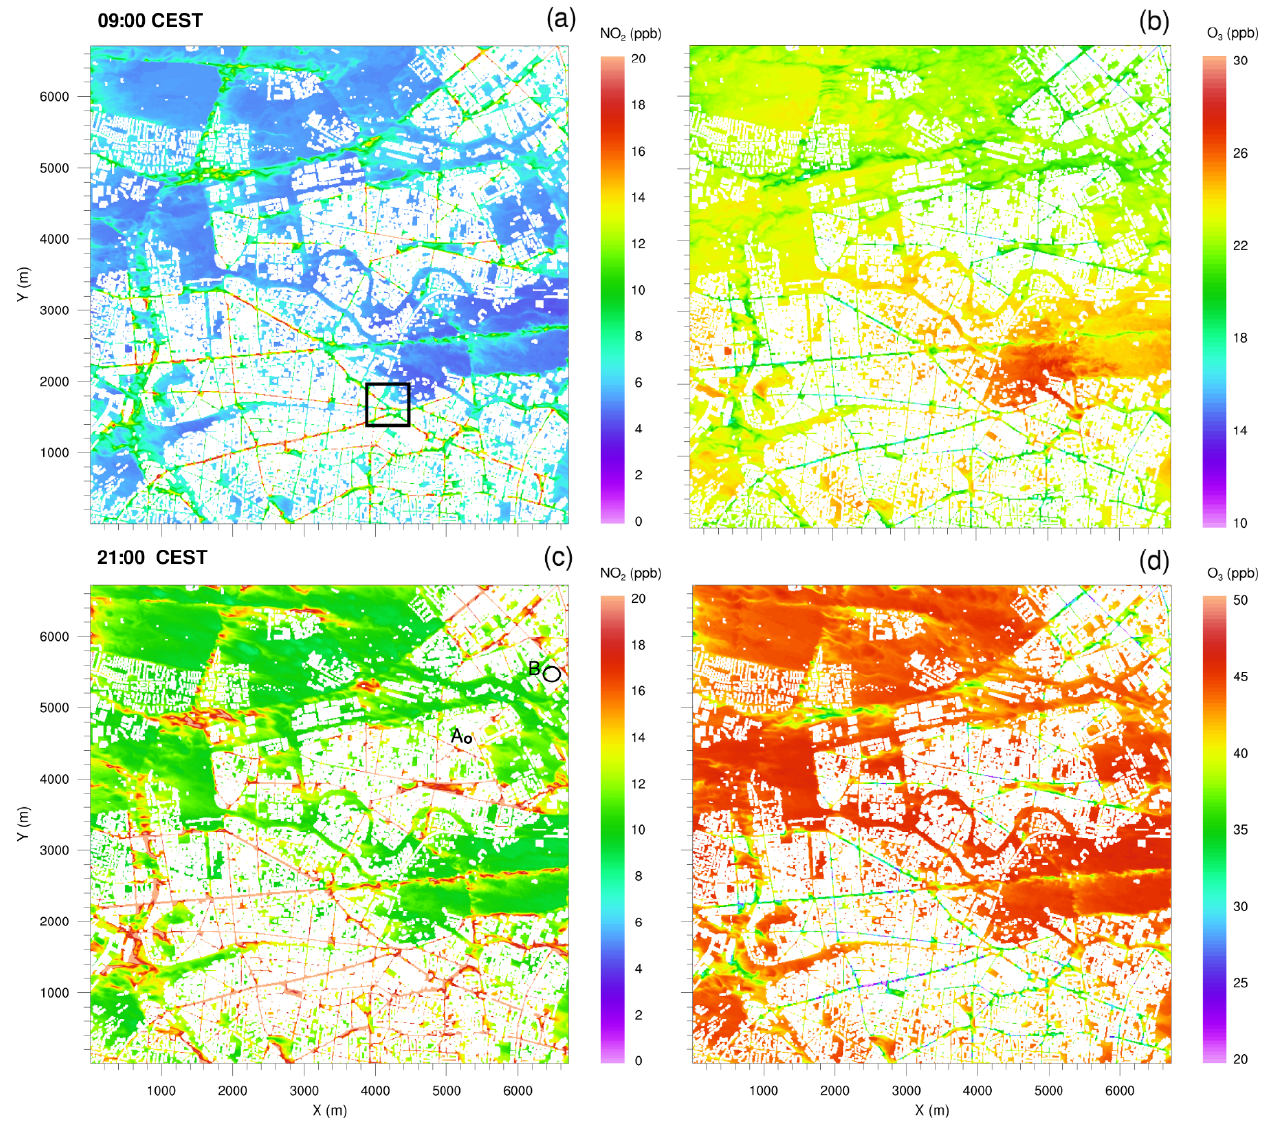
Figure 6. Horizontal cross sections of near-surface NO 2 and O 3 concentrations at 09:00 and 21:00CEST on 17 July 2017, simulated with the CBM4 mechanism. The black square in (a) indicates the location of the small domain presented in Fig. 7. Locations A and B in plot (c) indicates isolated street canyons plotted in Fig.